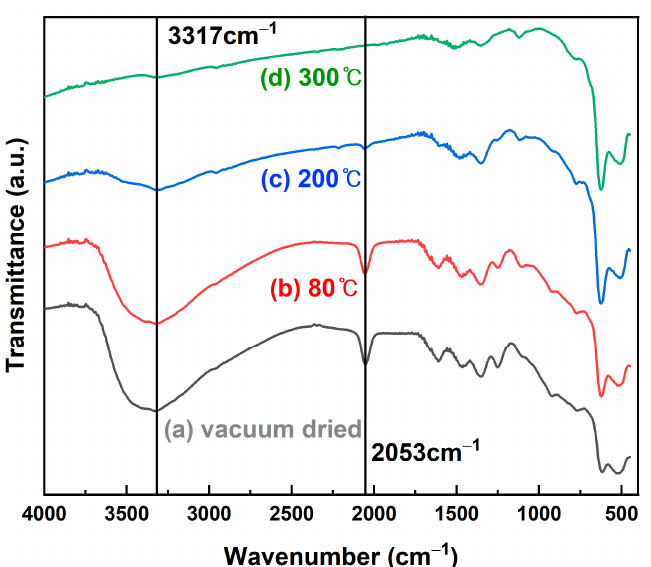
3 samples; ( b ) NaOH samples.